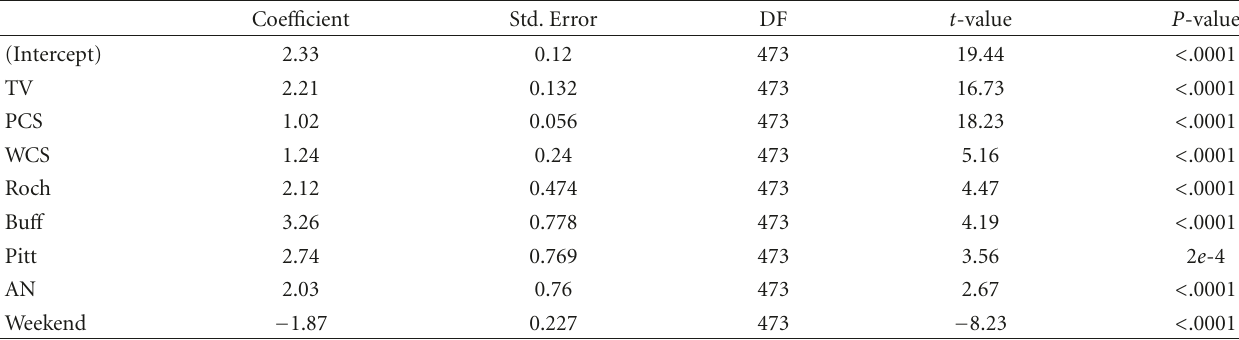
Table 3: Fixed e ff